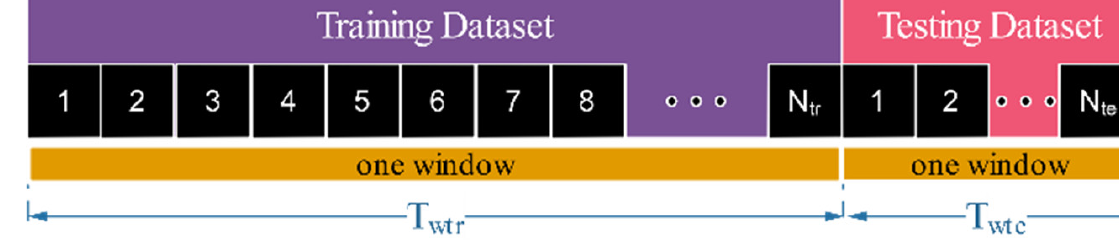
Figure 2. No resampling (NoR).